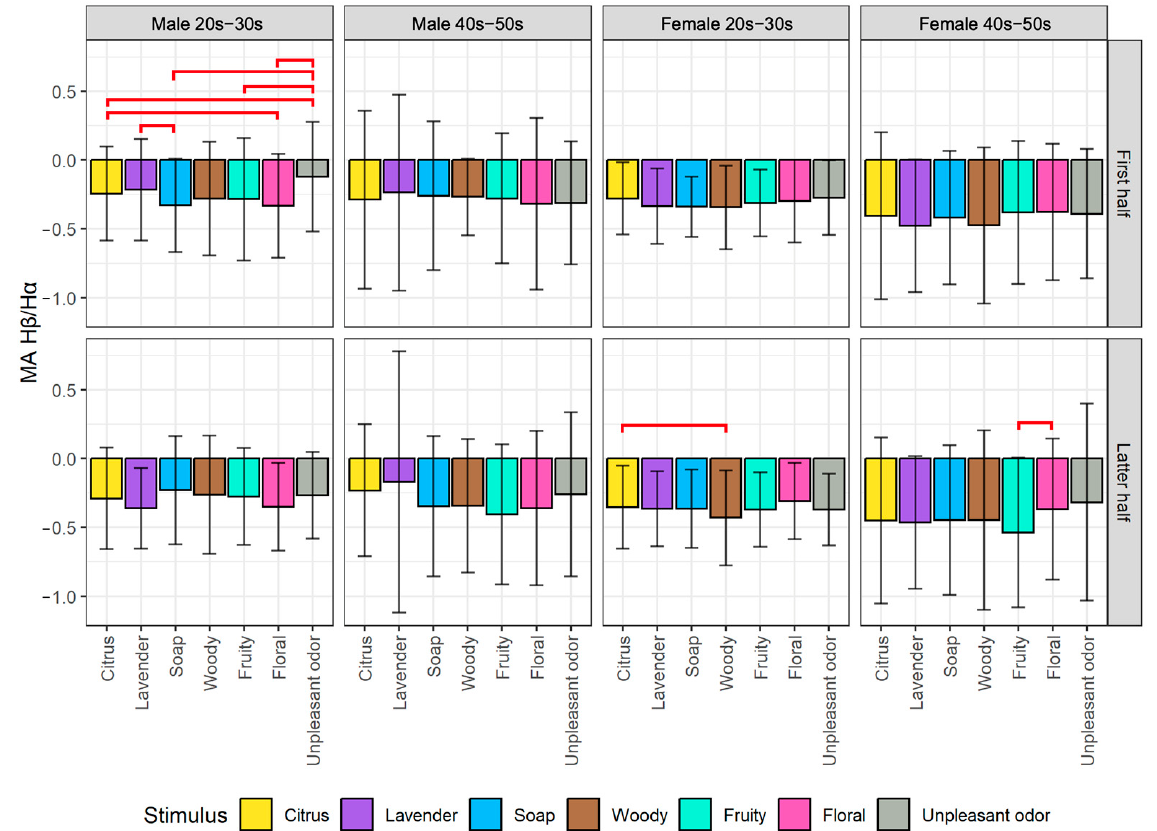
Figure 6. Comparison of changes in MA H β /H α among stimuli by gender and generation groups divided into the first half (top) and latter half (bottom) of stimulus exposure time. The red lines indicate signi fi cant di ff erences between pairs of stimuli.